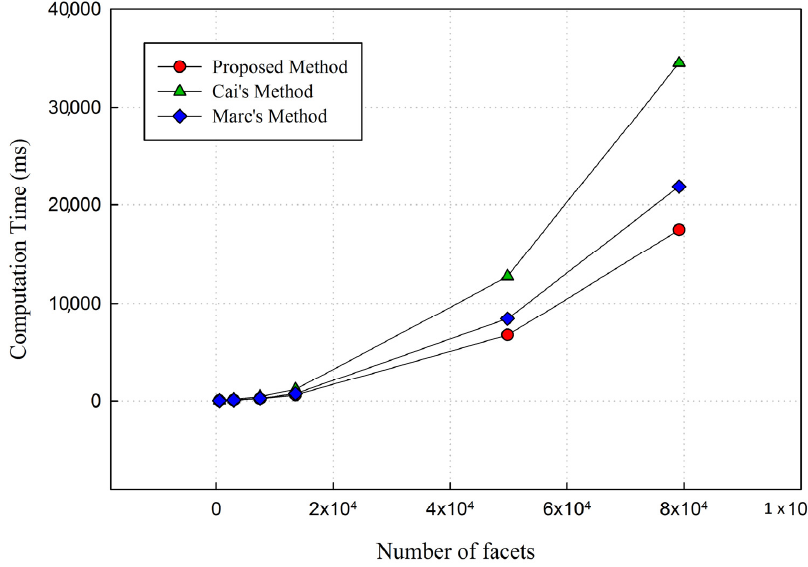
Figure 8. Computation time of the proposed method.